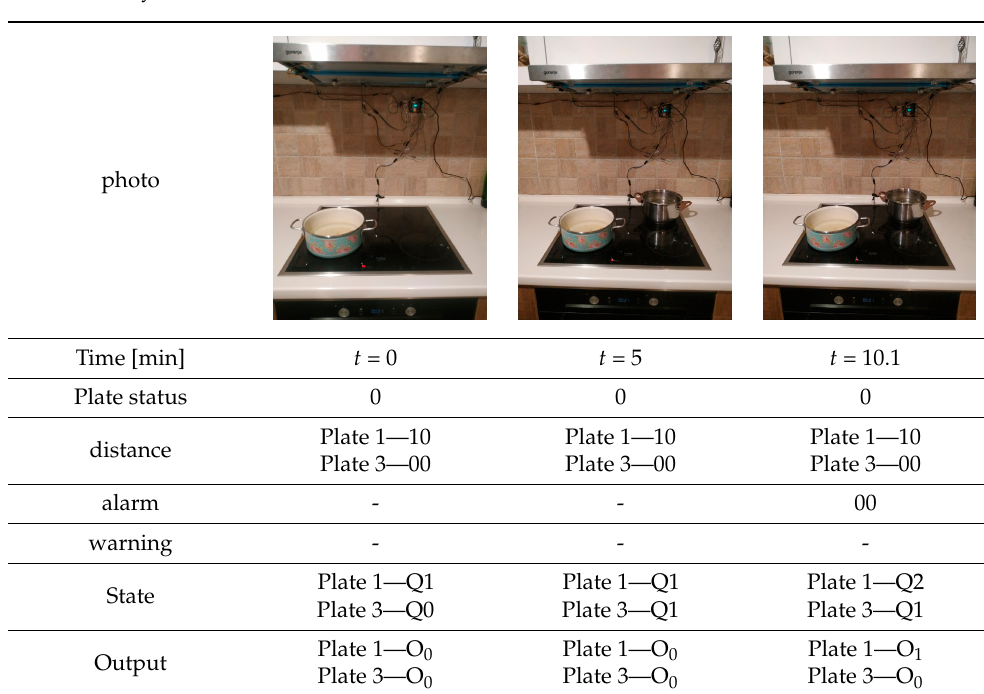
Figure 7. Test results of Scenario 3. Figure 6. Test results of Scenario 2. Table 5. Analysis of the results for test scenario 2: Plate 1 and Plate 3.